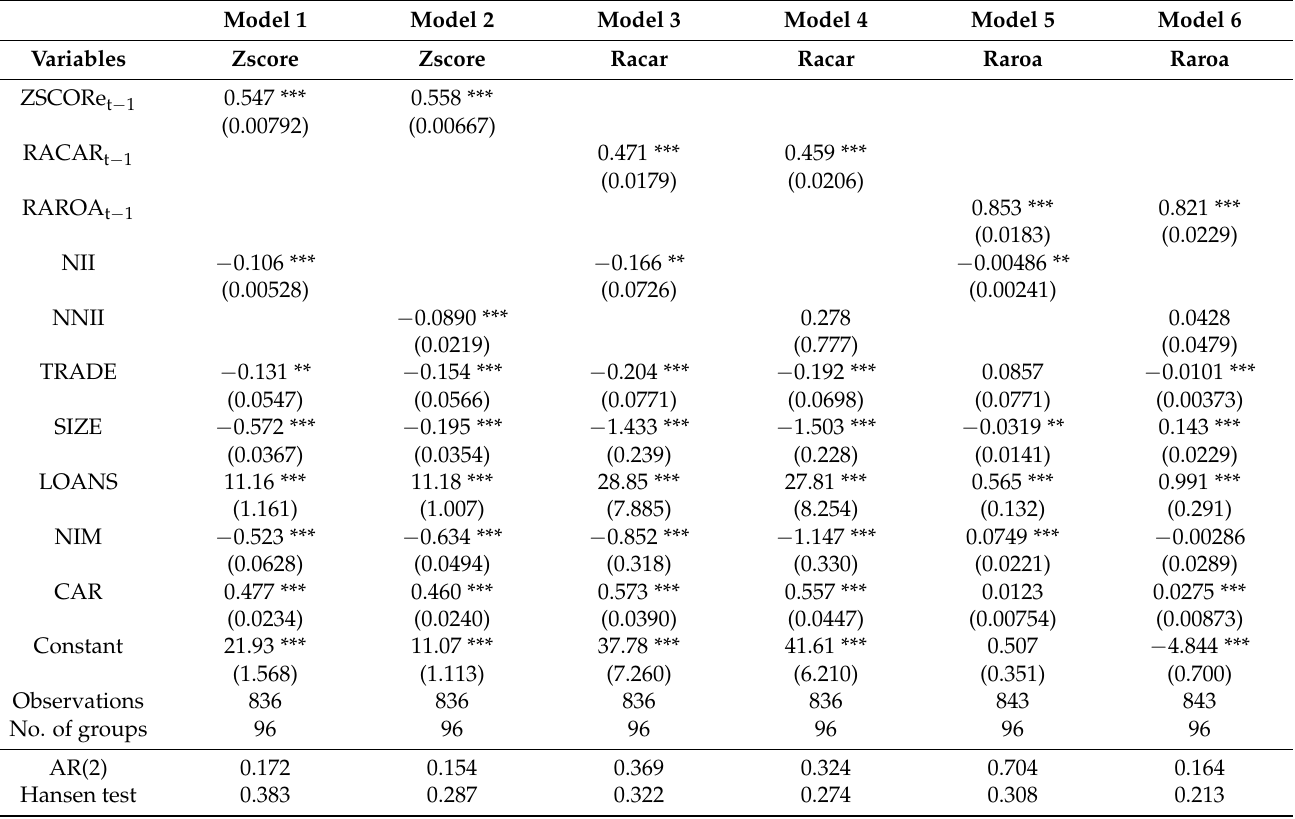
Table 6. Estimated results with GMM.